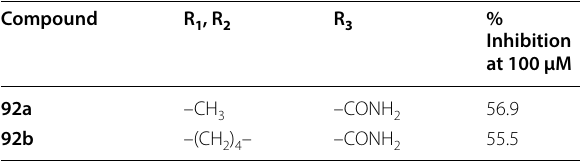
Doxorubicin a Drug concentration required to inhibit tumor cell proliferation by 50% after continuous exposure of 48 h. Doxorubicin was used as positive control